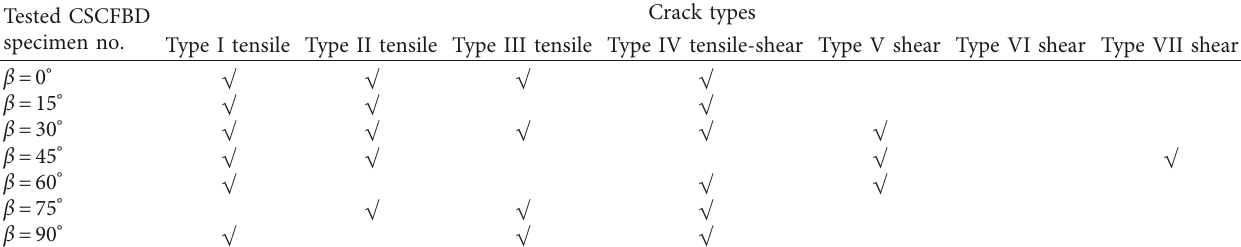
Table 2: Types of cracks initiated from pre-cracked CSCFBD specimens under cyclic impact loading. Tested CSCFBD specimen